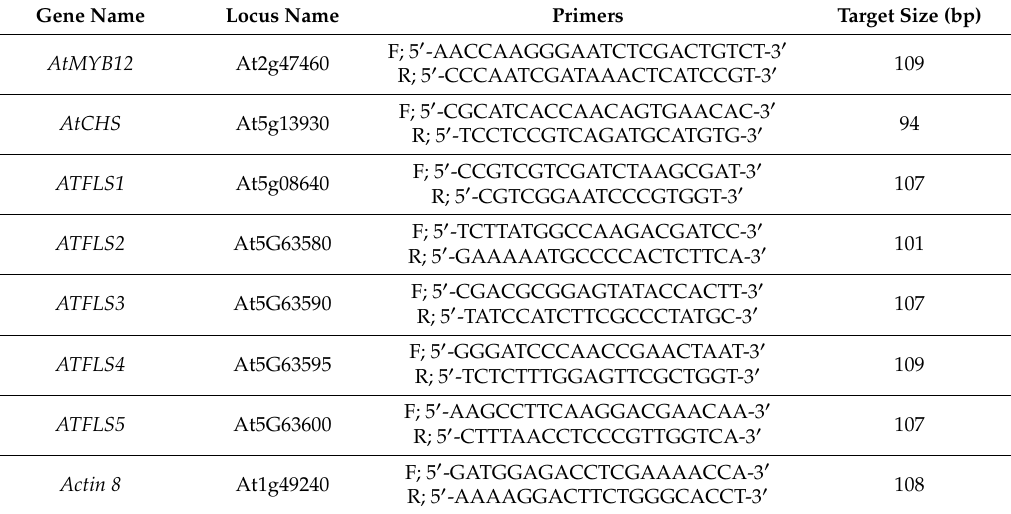
Table 1. Primers used in Real-time